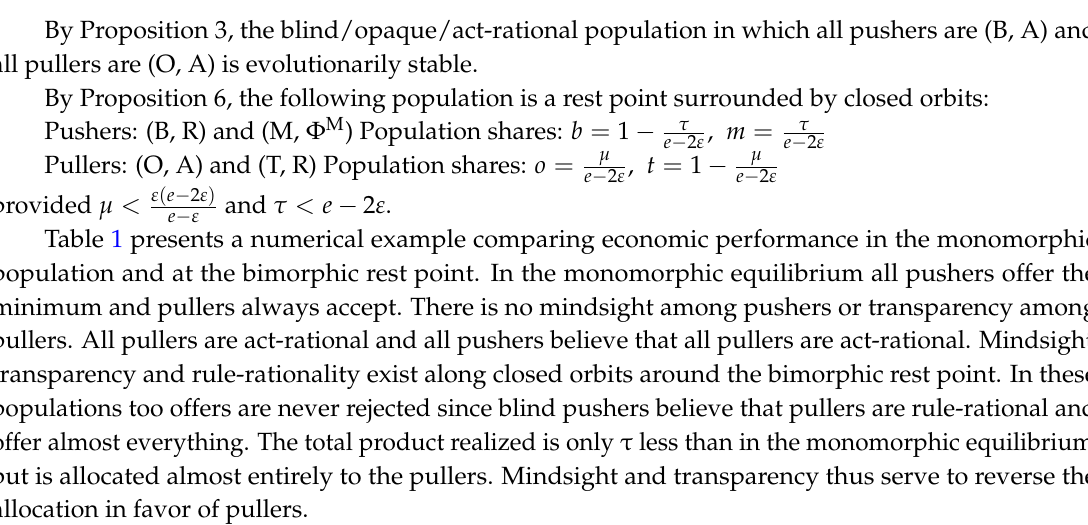
Table 1. Economic performance in the Ultimatum game in the monomorphic equilibrium consisting solely of act-rational agents without mindsight or transparency, and at the bimorphic rest point where act- and rule-rational agents